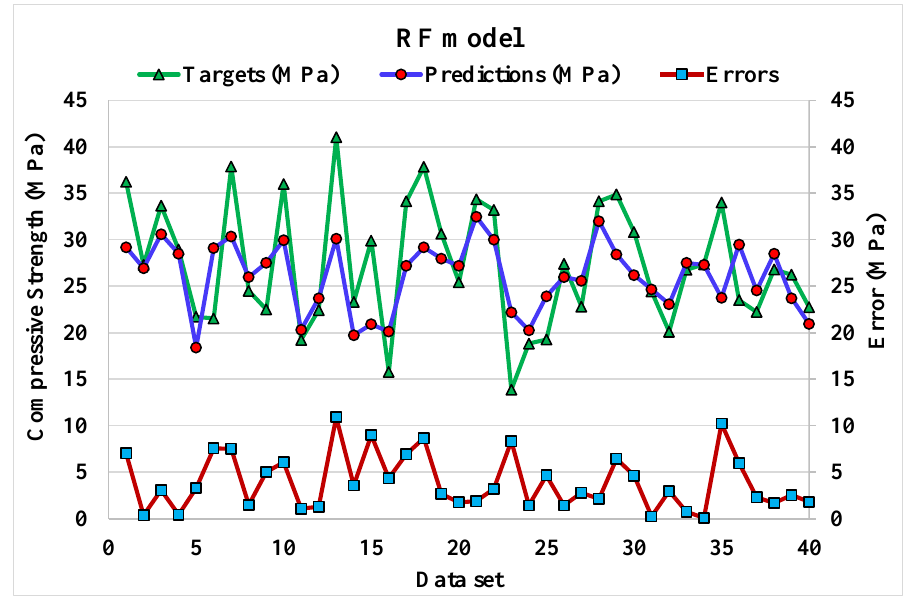
Figure 13. Dispersion of predicted and actual values along with errors for RF model.